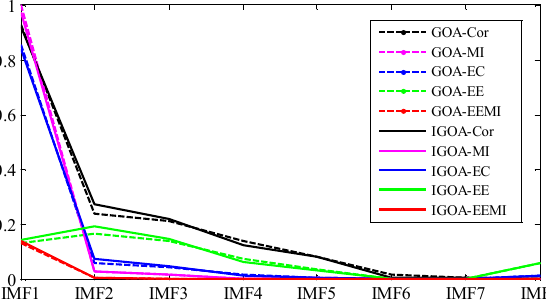
Figure 23. Decomposition results evaluation of rolling element slight damage signal.